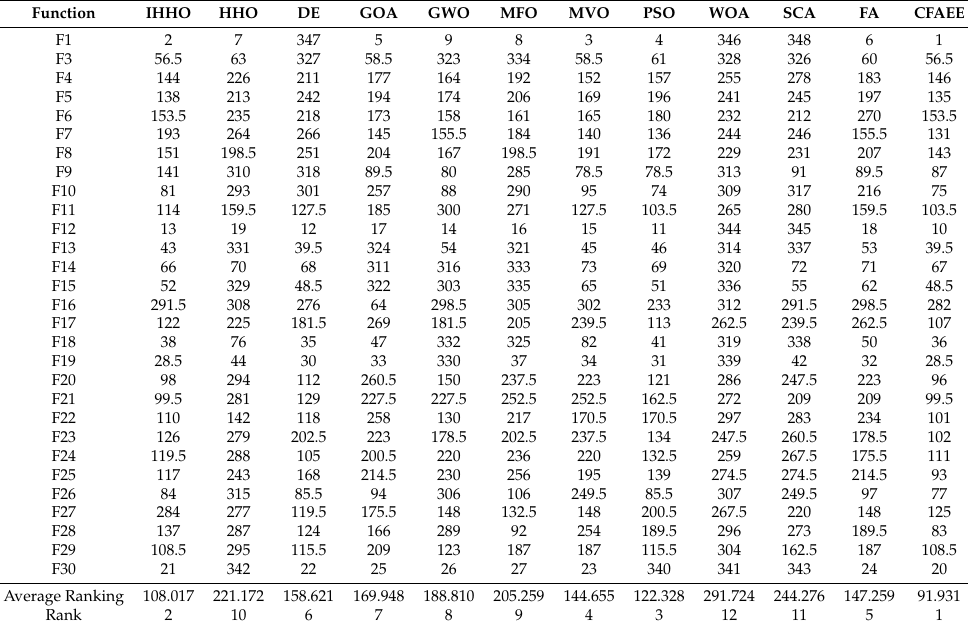
Table 12. Aligned Friedman test ranks for the compared algorithms over 30 CEC2017 functions.